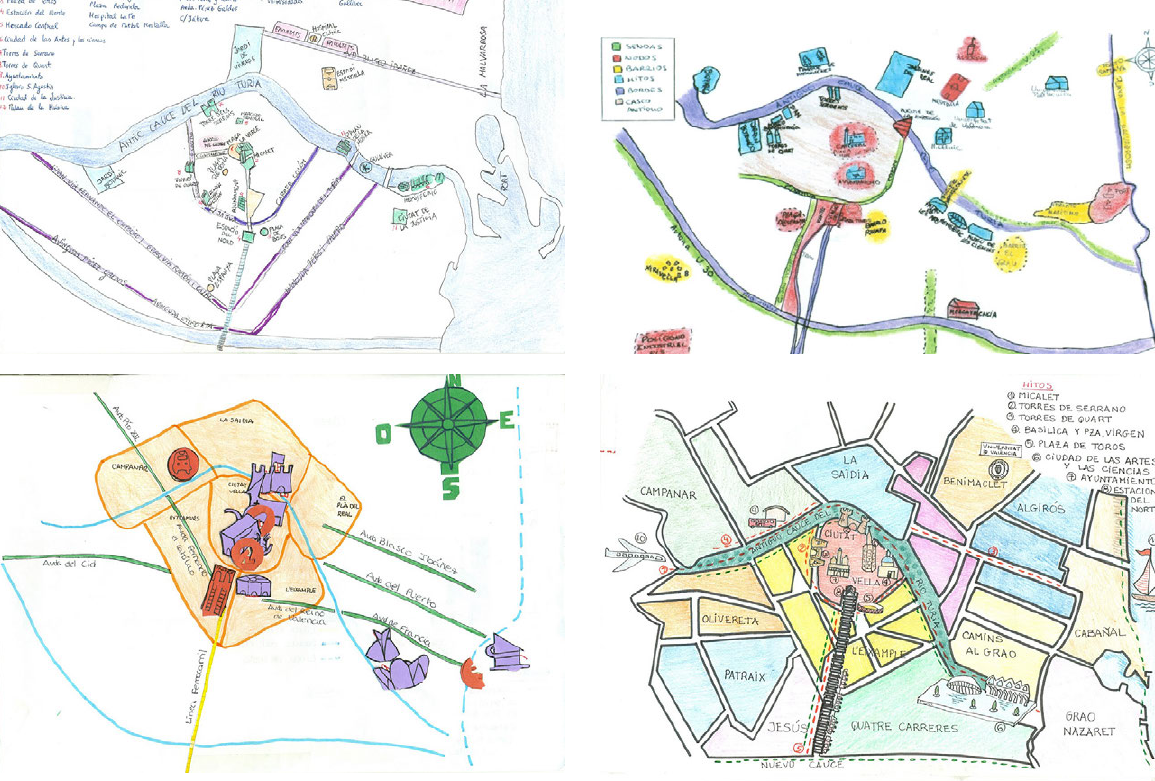
Fig. 6. Drawings of perceptions of Valencia made in groups of 6–9 university students of